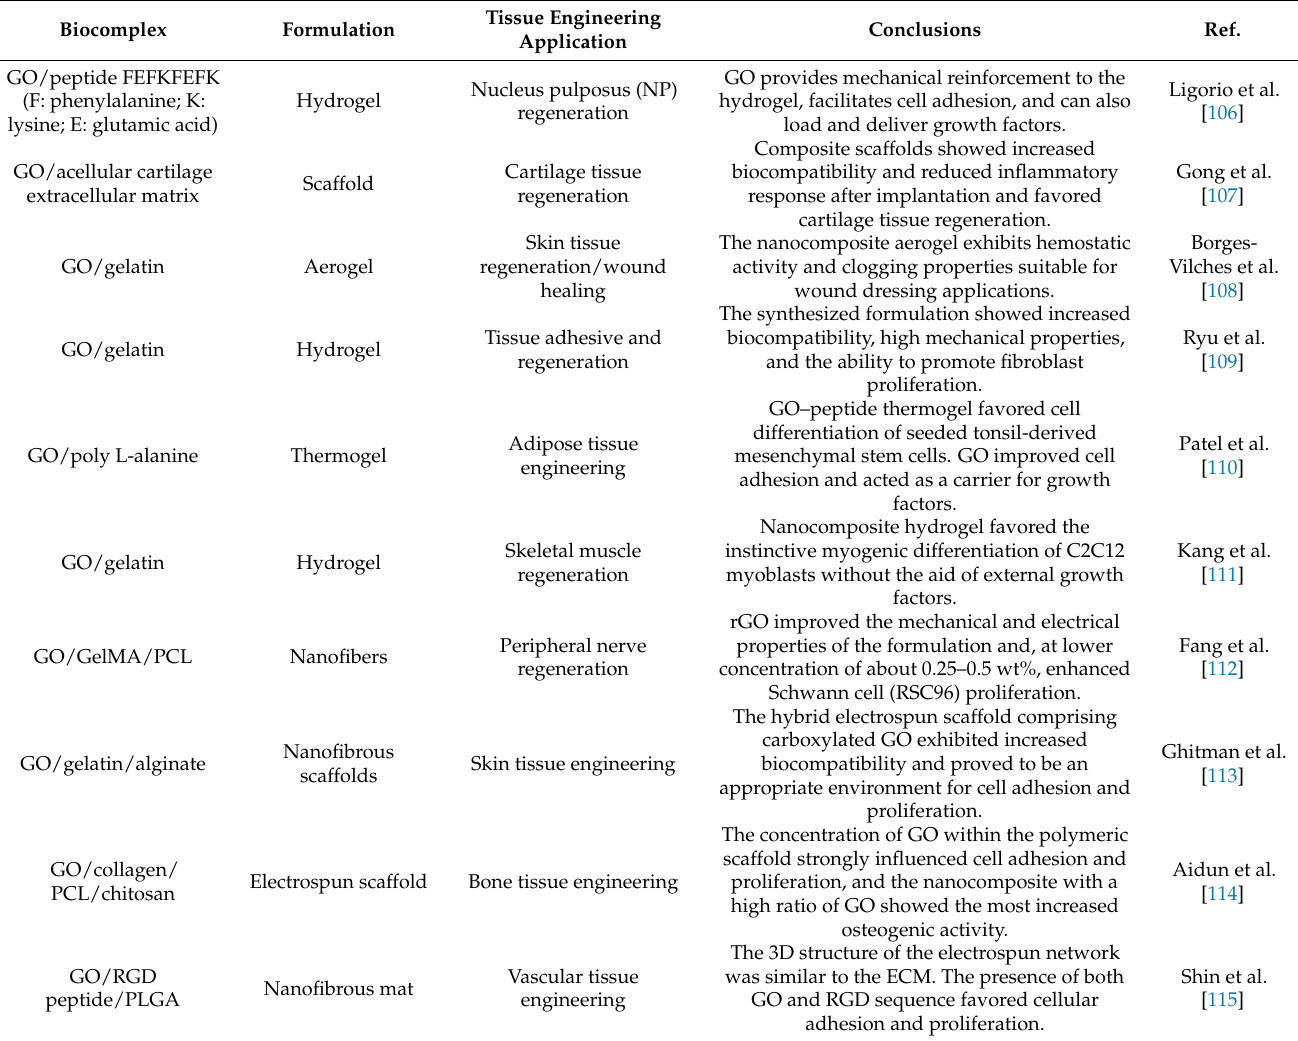
Table 1. Tissue engineering applications of GO-protein/peptide